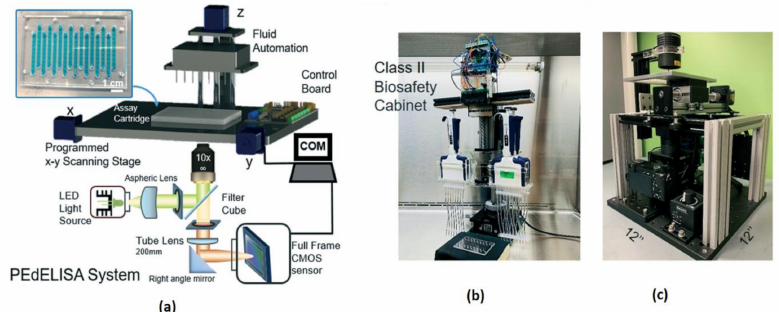
Figure 34. ( a ) Pre-equilibrium digital enzyme-linked immunosorbent assay (PEdELISA) system- photo image. ( b , c ) PEdELISA system schematic in a bio-safety cabinet. Figure adapted with permis- sion from [39].